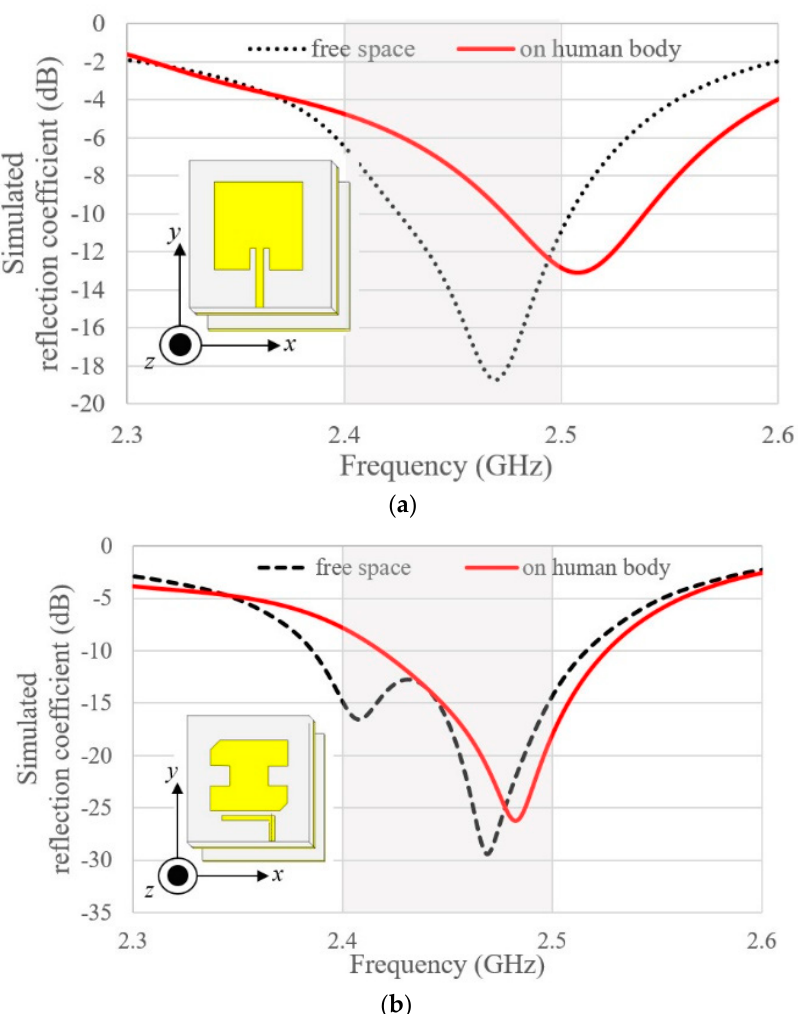
Figure 8. Shift in resonance frequency due to human body loading effect. ( a ) D-fed Rect-MSA; ( b )